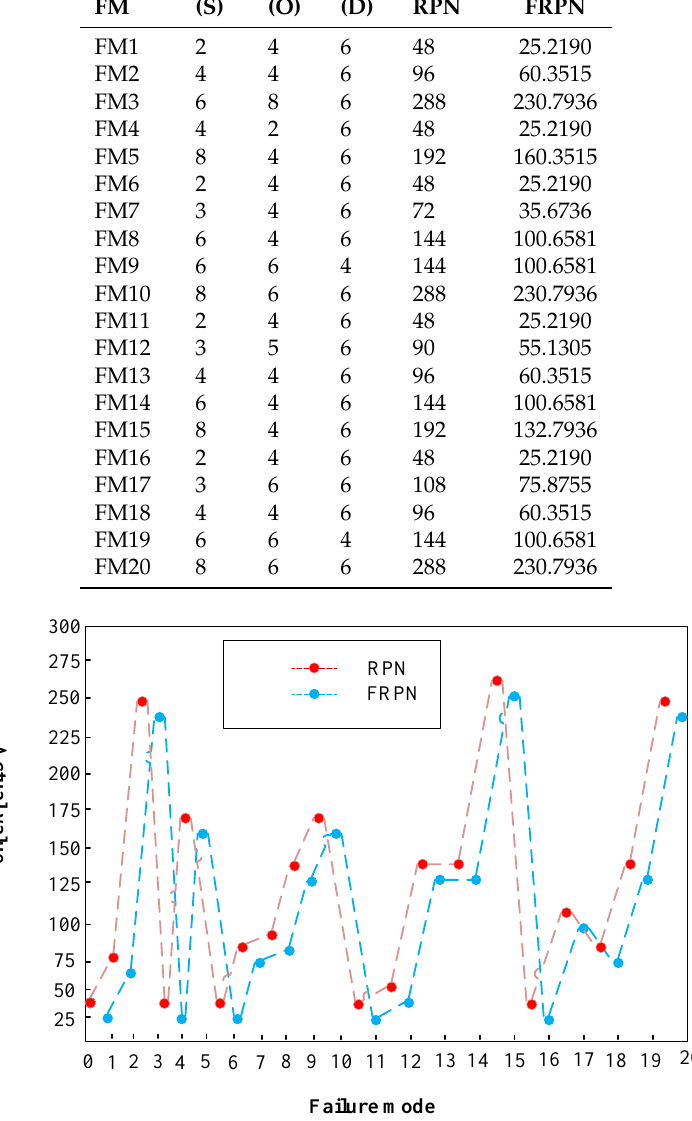
Figure 4. Numerical comparison of MDF continuous hot pressing process deviation grades, risk probability number (RPN) and fuzzy risk probability number